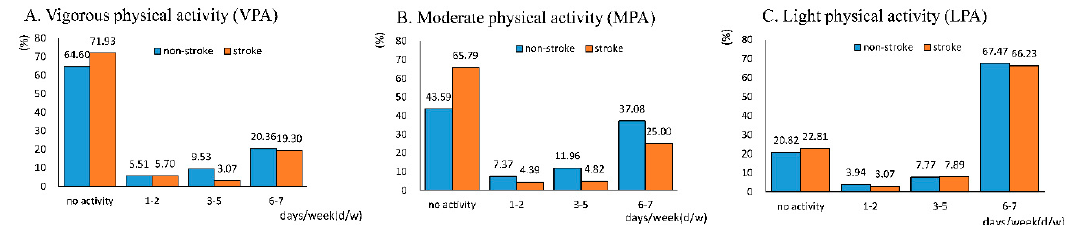
Figure 1. Frequency of vigorous physical activity (VPA) ( A ), moderate physical activity (MPA) ( B ), and light physical activity (LPA) ( C ) in participants with and without stroke. The height of the column represents the proportion of individuals at this level of frequency in total participants with and without a stroke, respectively. Corresponding proportion is shown above the column.